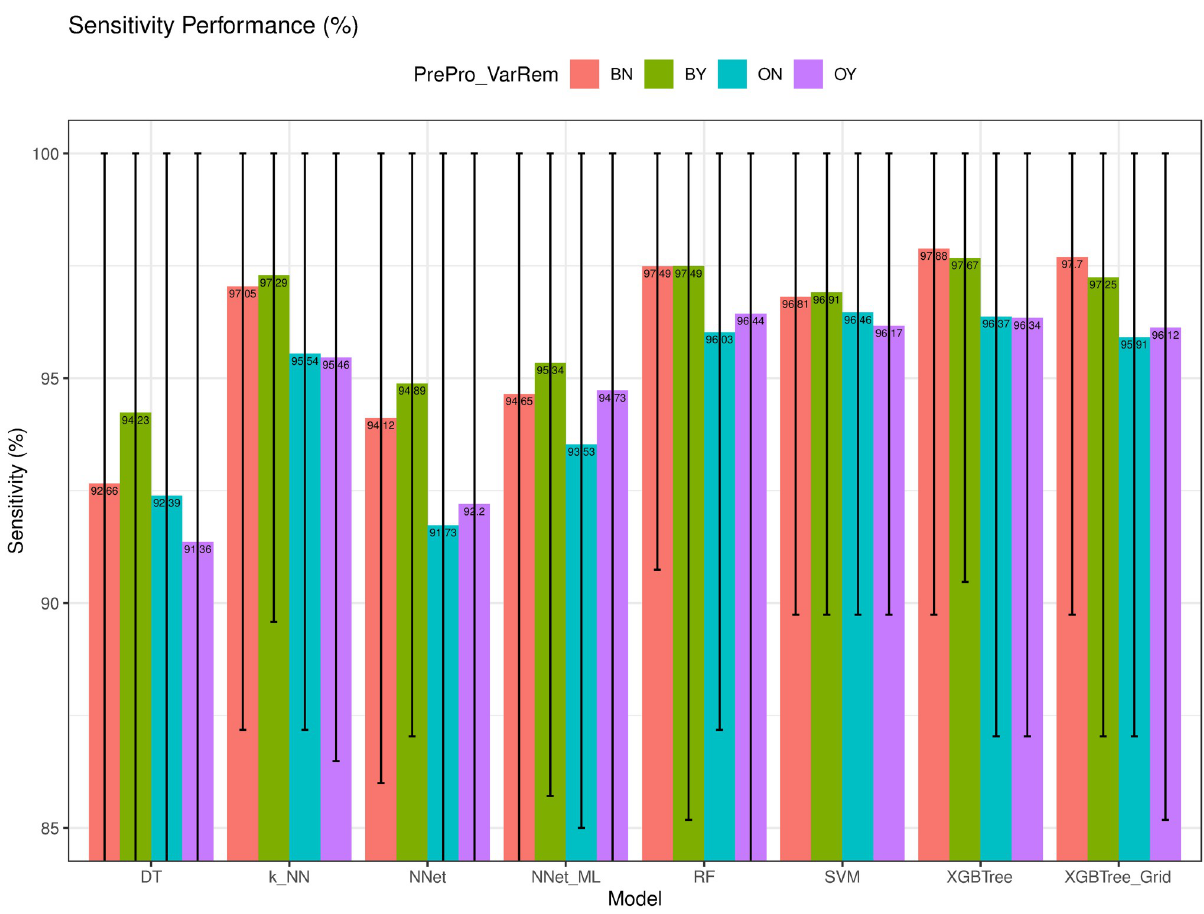
Fig 10. Sensitivity ( Sen ) of different